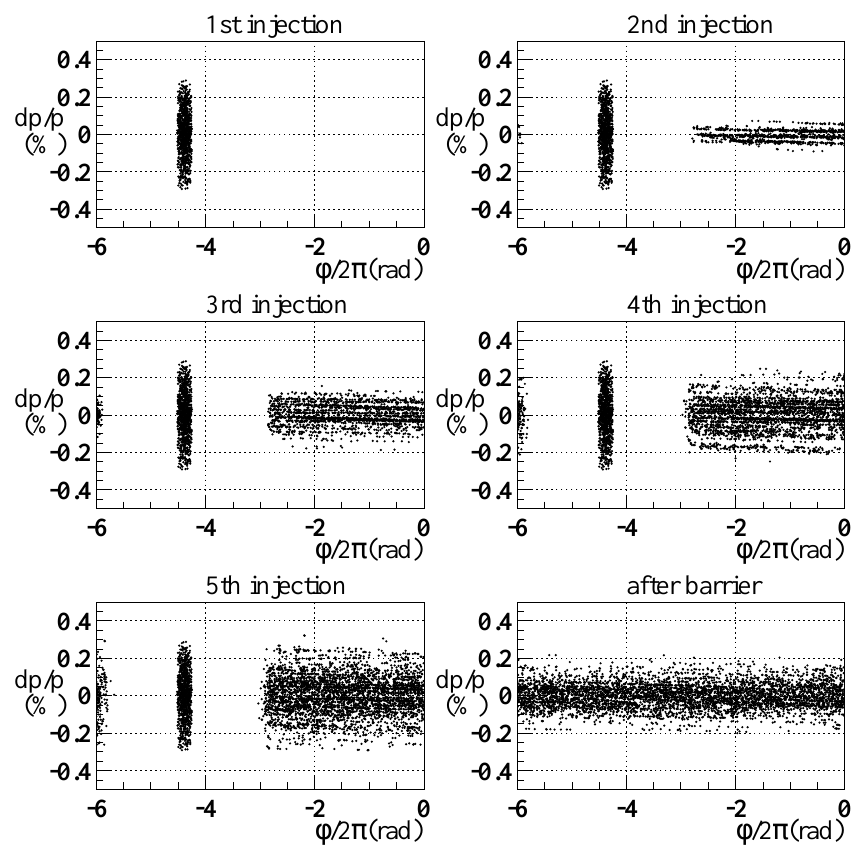
FIG. 17. Phase-space configurations at every injection. The horizontal and vertical coordinates are the rf phase and momentum spread. The intensity of one bunch is set at 8 3 10 12 protons. The bunch width and initial momentum spread are set at 24 ± and 6 0.003 , respectively. The phase gap between the barriers is 97 ± , which is equal to the pulse width of the injection